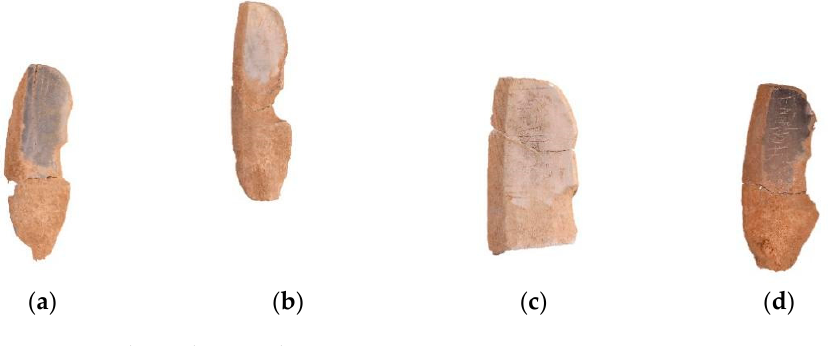
Figure 8. Traditional ORB splicing.